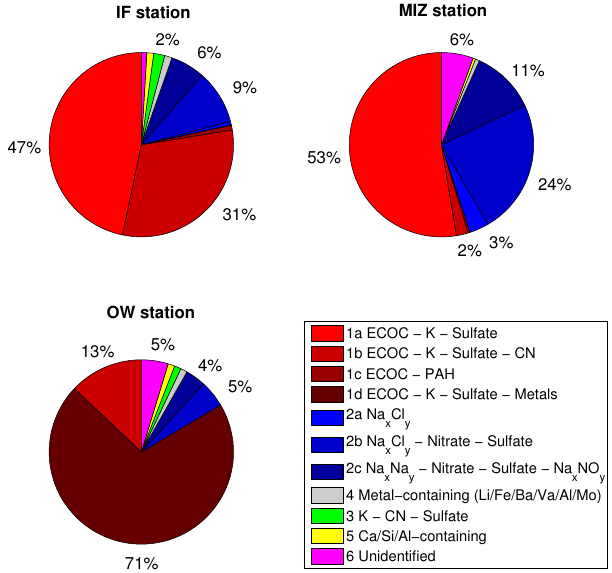
Figure 3. Number-based pie chart of the aerosol clusters for the IF, MIZ and OW station. A fraction of less than 1% is not labeled in the figure for